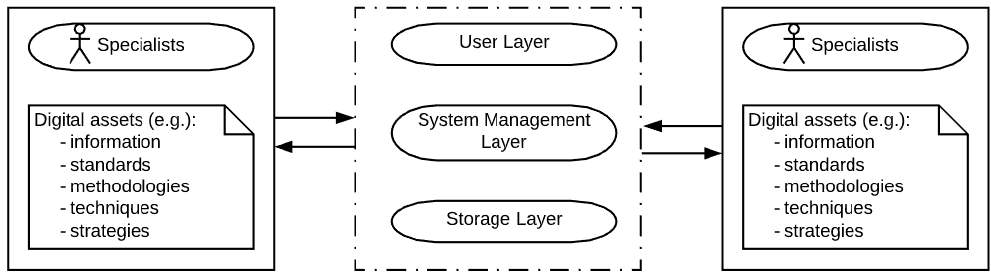
Figure 8. Scenario: iteration of specialists in the management, storage, and/or sharing of digital assets.